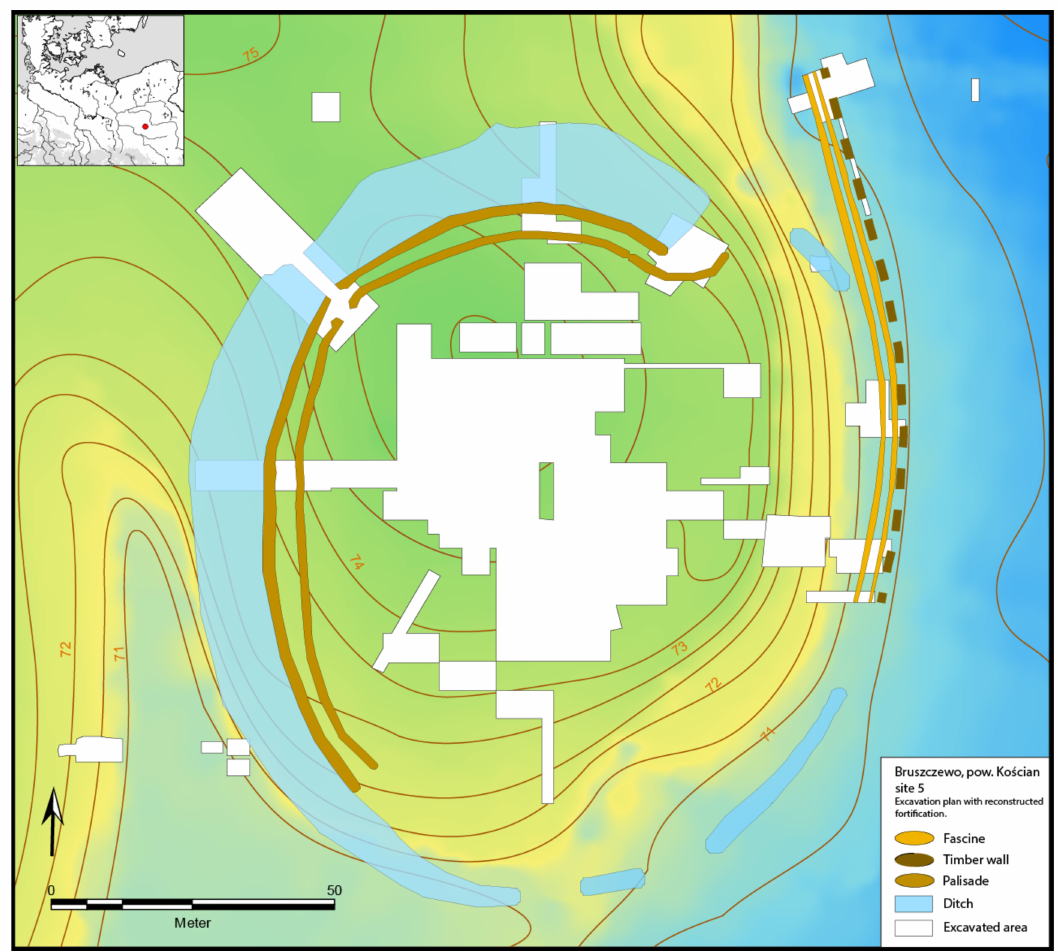
Figure 2. Bruszczewo